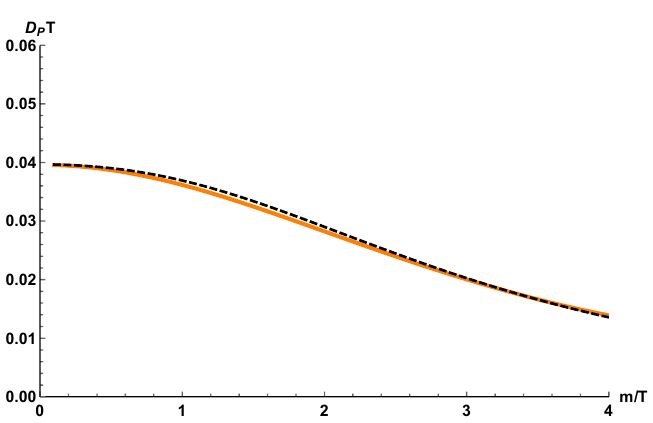
Figure 8 . The comparison between the damping coe(cid:14)cient D p extracted from the numerical data (solid line) and the hydrodynamic formula (3.22), for the speci(cid:12)c N = 5. We found similar results for several N > 5 =